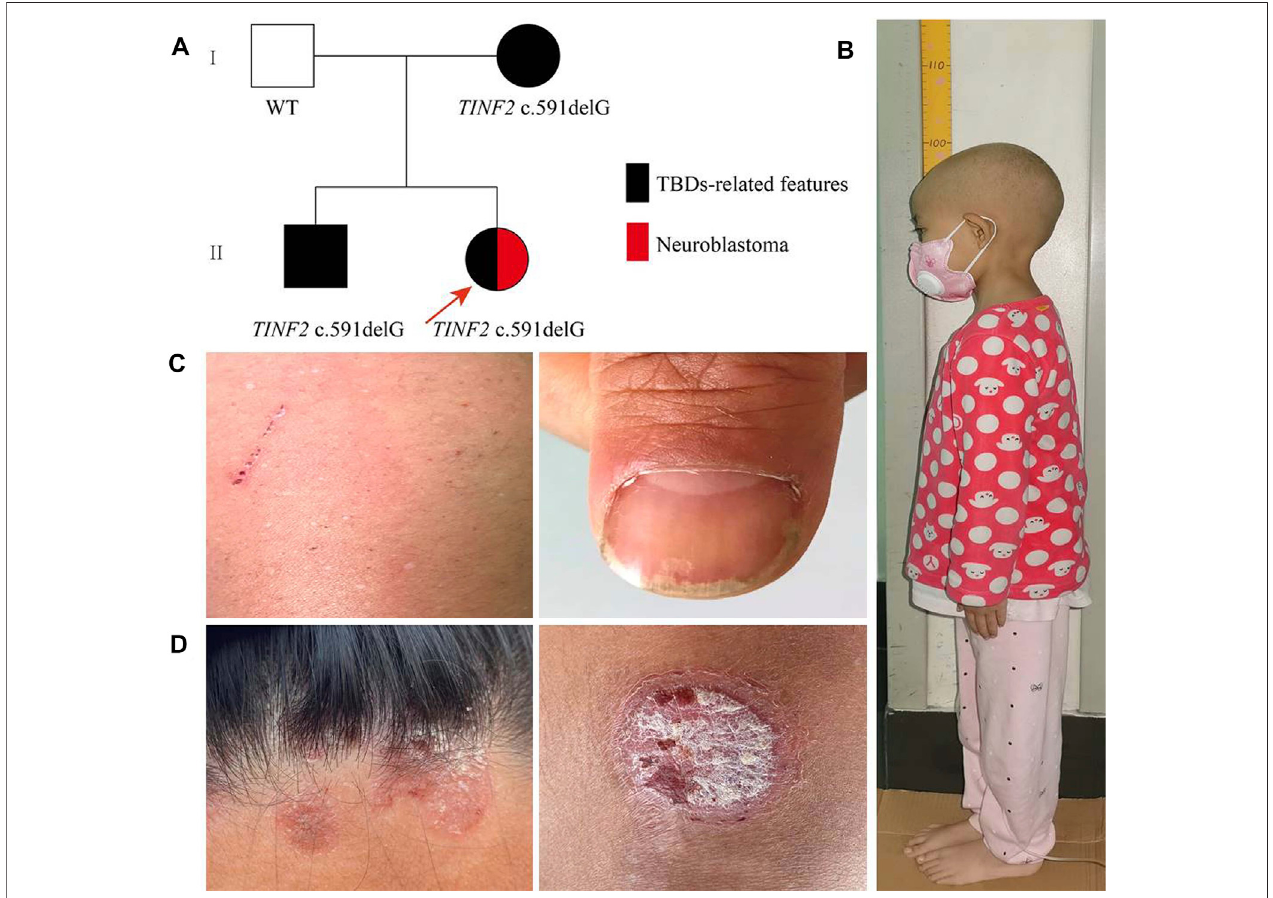
FIGURE 1 | Family pedigree and clinical phenotypes. (A) Family pedigree males are marked as squares and females as circles. An arrow indicates the proband. Black symbols, individuals with TBDs-related features; red symbols, individuals with Neuroblastoma. (B) The height of the proband was 96.8 cm for 6 years and 3 monthsold. (C) Theproband ’ smotherpresentednaildystrophyanddepigmentationoftheskin. (D) Theproband ’ solderbrothermainlymanifestedasredrasheswith white scales on the surface on his limbs and hairline, which was aggravated in winter and improved in summer.